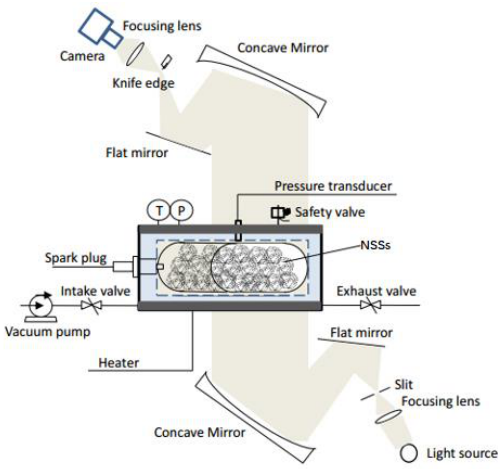
Figure 2. Schematic of experiment setup.